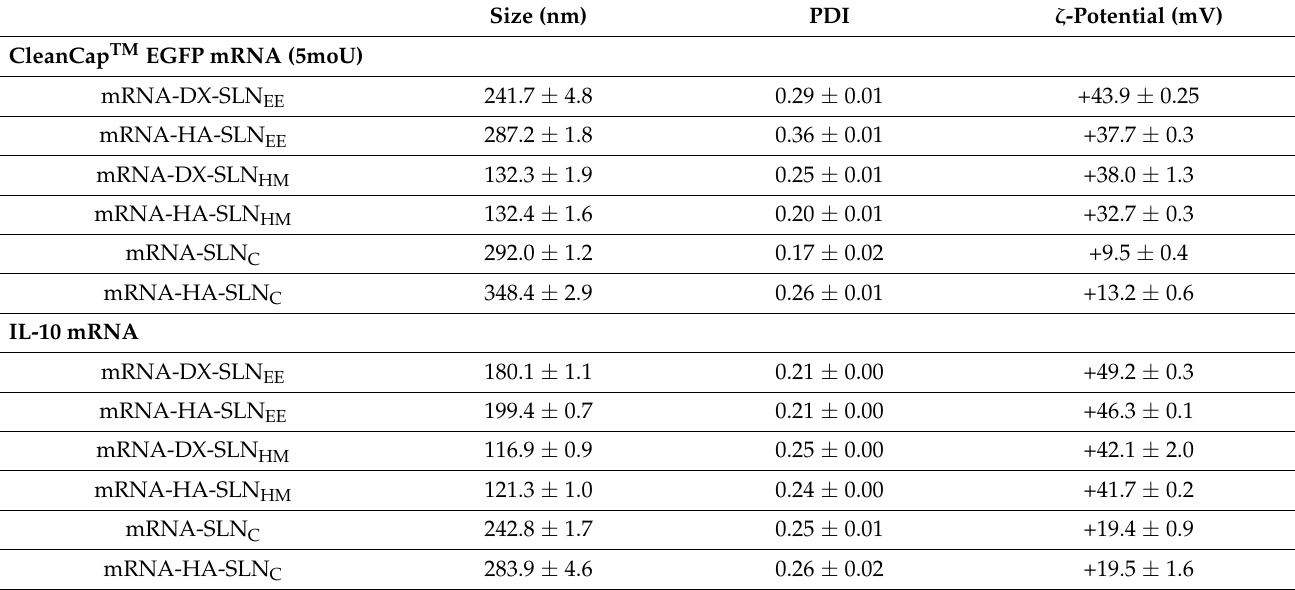
Table 3. Physical characterization of mRNA-based vectors.